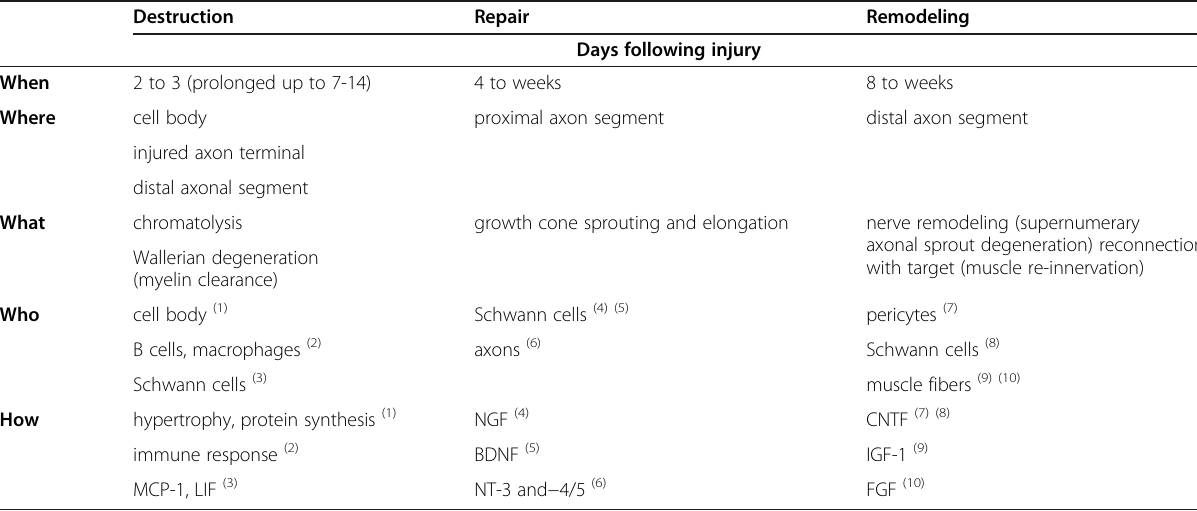
Table 2 Kinetics of wound healing of the nerve: main phases and players Destruction